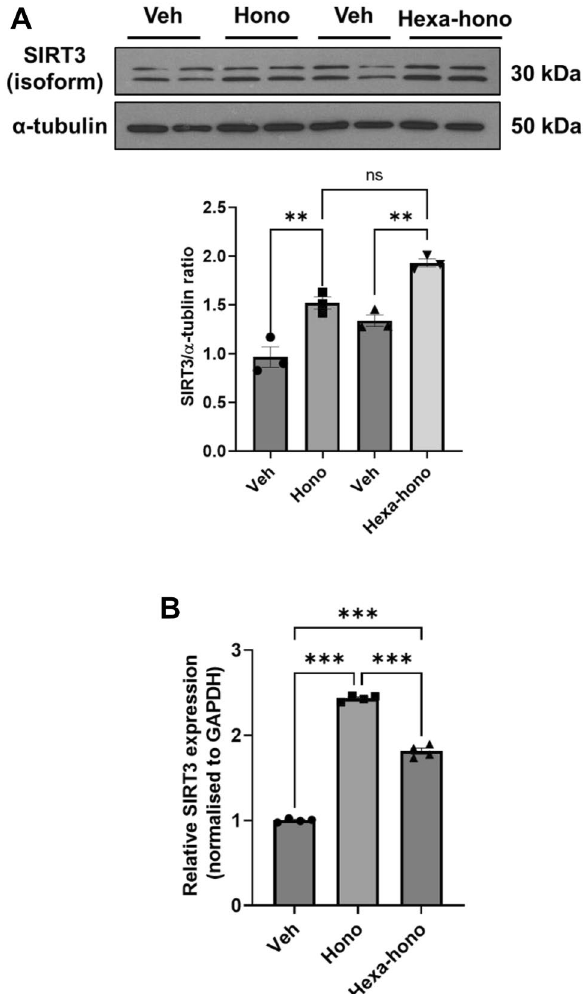
Figure 3. Honokiol and Hexafluoro-honokiol increase the mRNA and protein expression levels of SIRT3 in primary myenteric neurons and IM-FEN cells. ( A ) Western blot analysis was performed with protein lysates from IM-FEN cells treated with vehicle, Honokiol, or Hexafluoro, cultured for 24 h, and probed for SIRT3 protein and α-tubulin protein as a loading control. The histogram shows the SIRT3 band density normalized to α-tubulin. ( B ) Quantitative RT-PCR was done using primary myenteric neurons treated with Vehicle, Honokiol, or Hexafluoro for 24 h. The histogram represents a fold increase in SIRT3 expression in treated cells compared to vehicle treatment. The uncropped Western blot images of Fig. 3A have been provided in the supplementary file. Both protein of interest and loading control were run on a single membrane. Data are the mean ± SEM from three independent experiments. ns = non-significant; ** P < 0.01; *** P < 0.001; (2-way